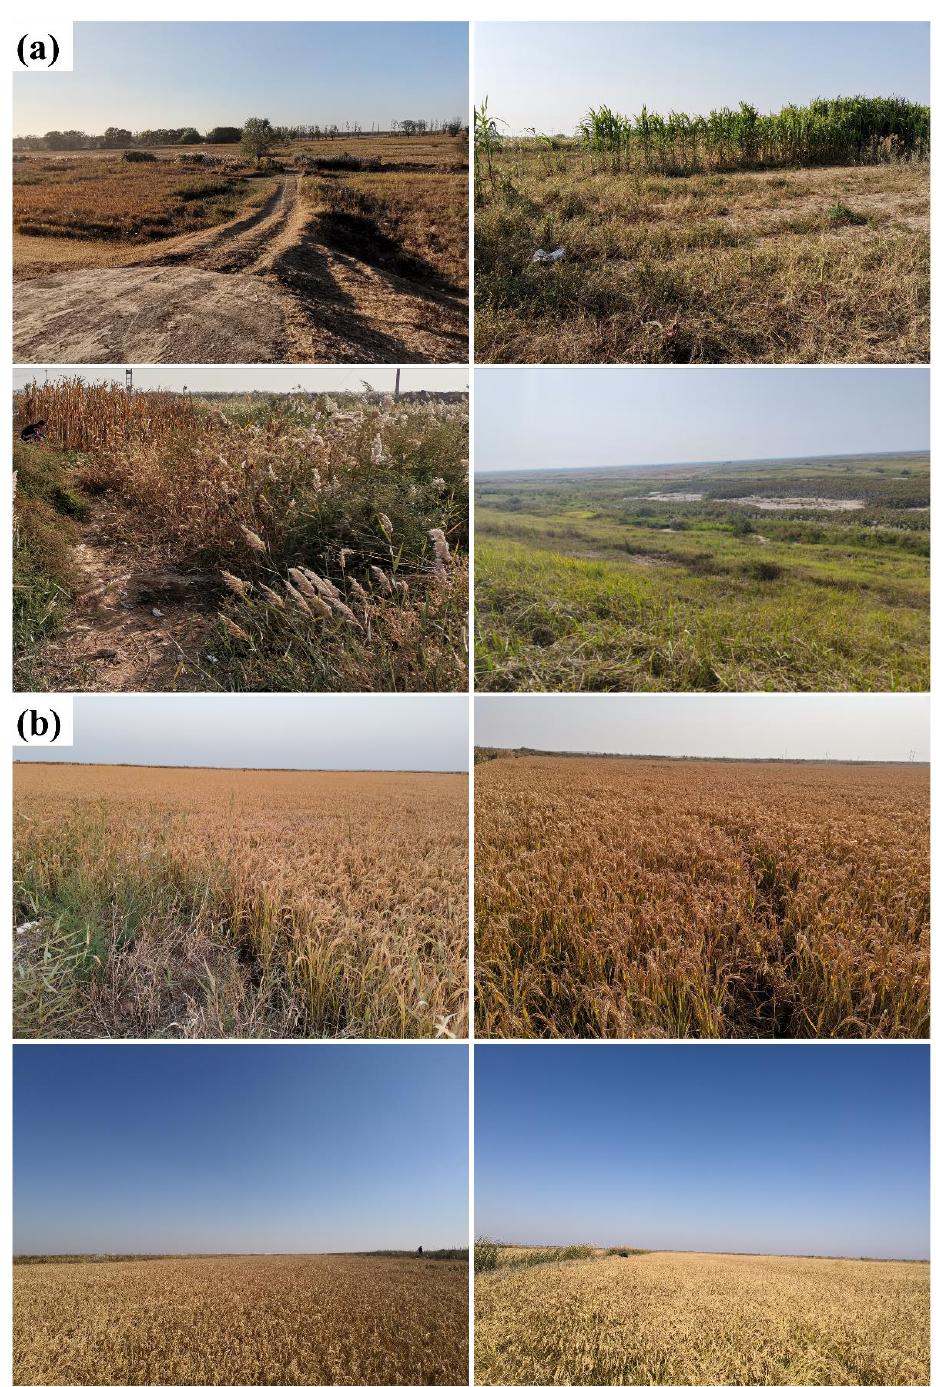
Figure 10. Field survey for ( a ) potential HNVf features and ( b ) intensive farmland in the study